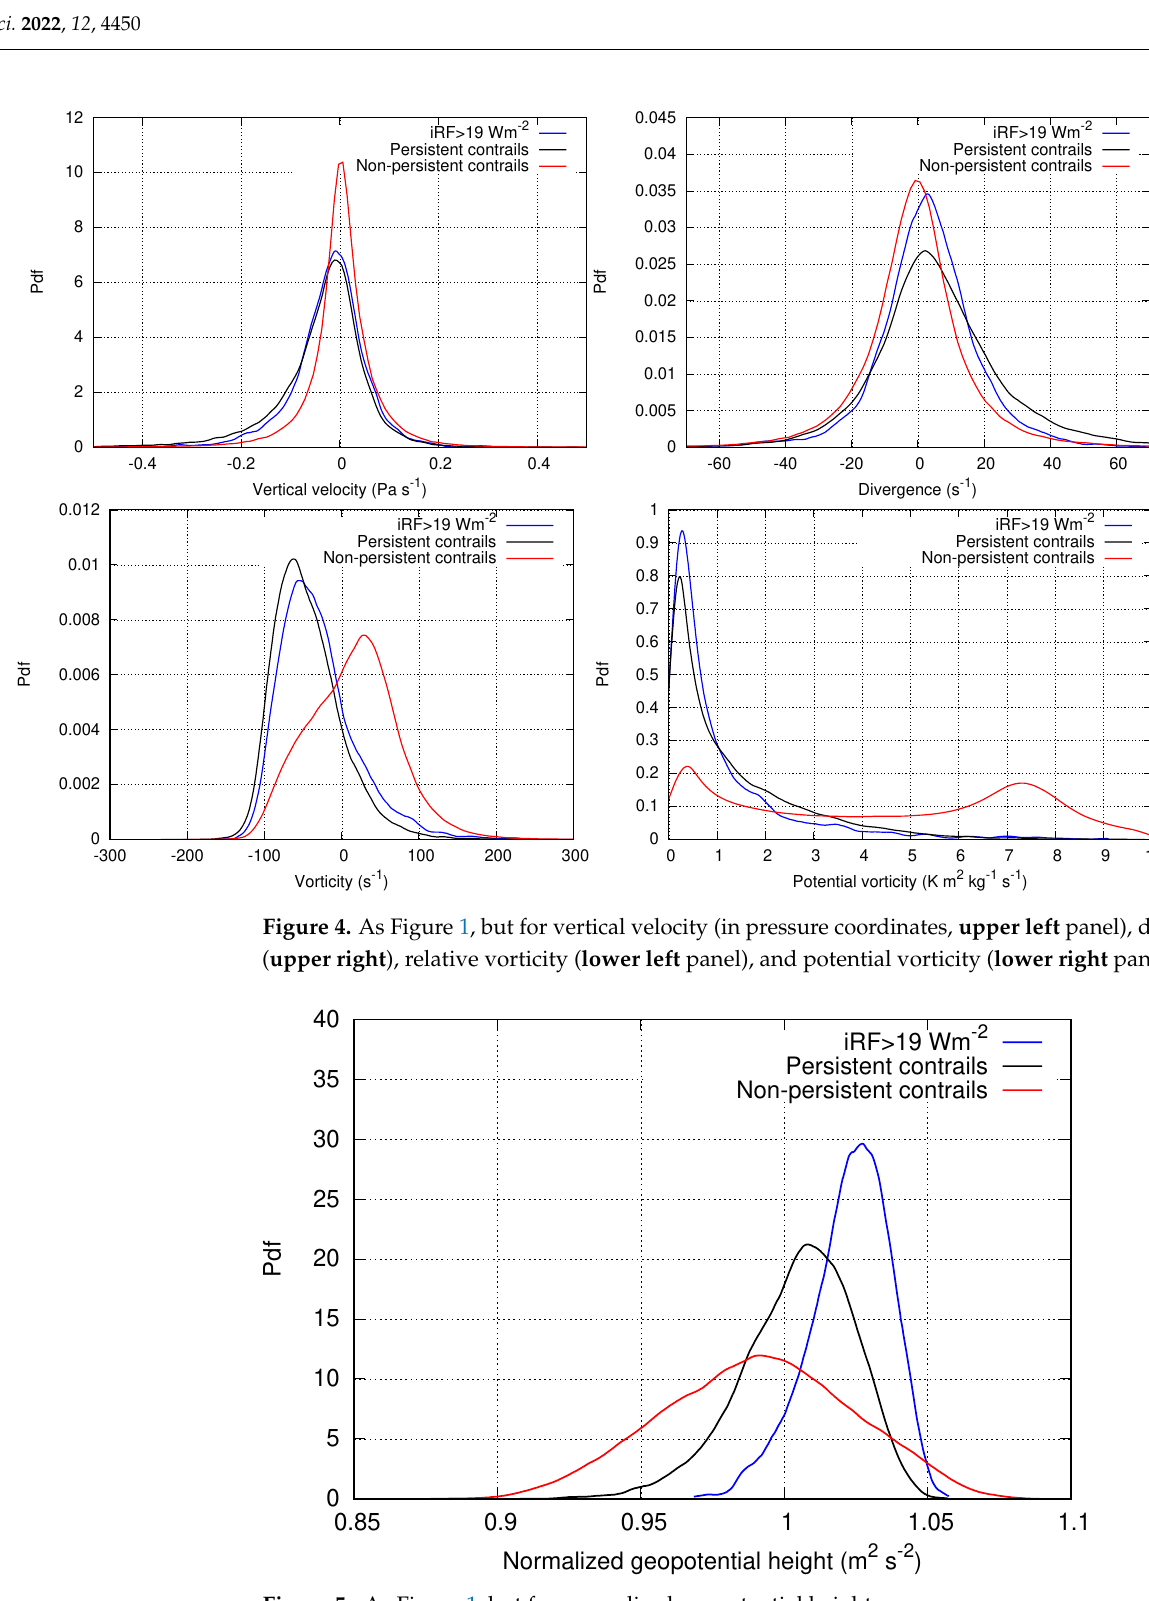
Figure 5. As Figure 1, but for normalised geopotential